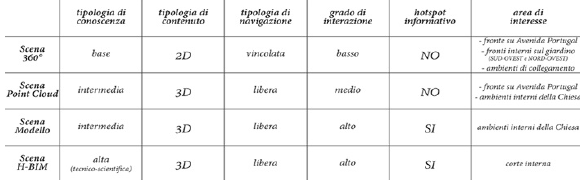
Figure 6: Comparative synthesis of the characteristics of the four scenes designed for the VR App of the Simón Ruiz Hospital.